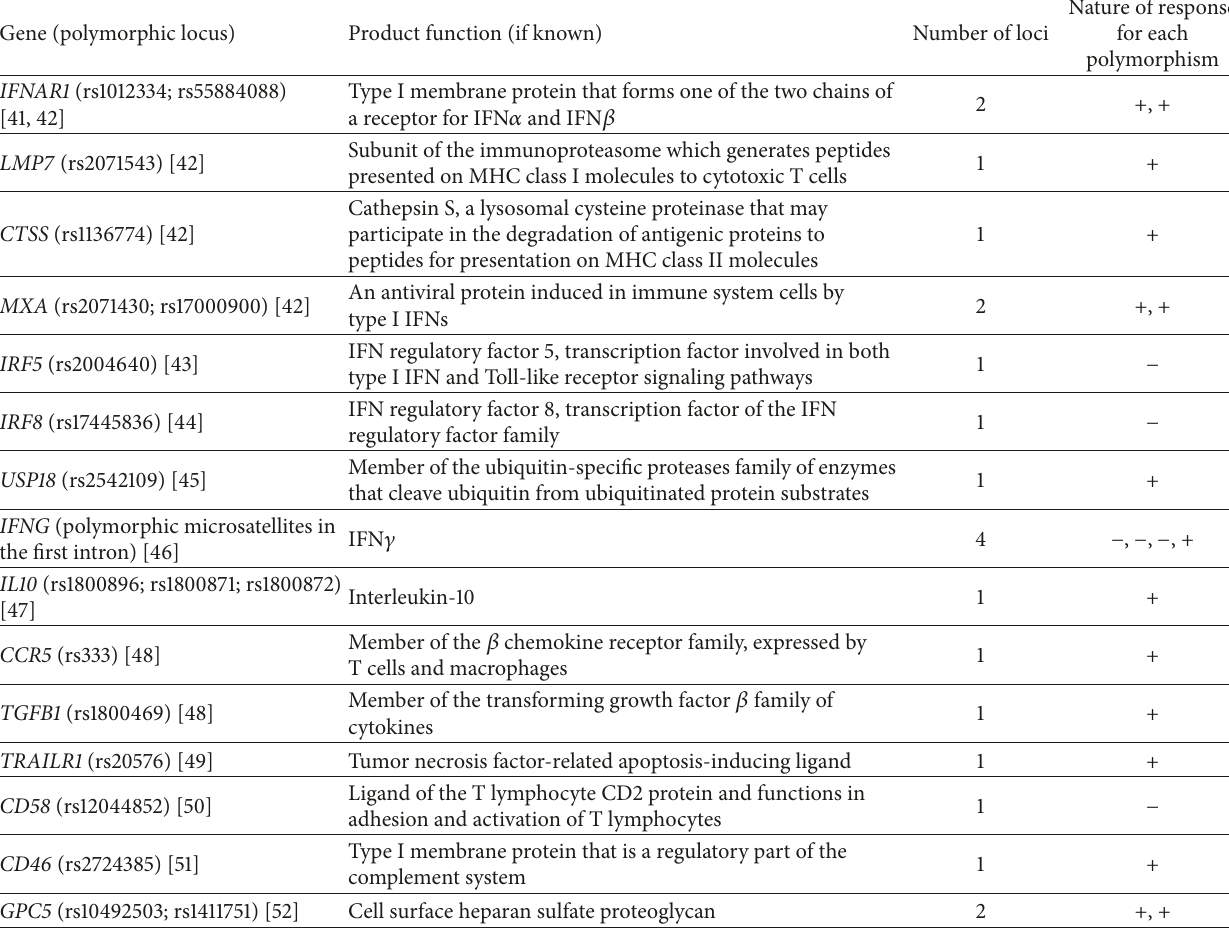
Table4:GeneswithpolymorphismsshowingsignificantassociationwithresponsetoIFN 𝛽 inpatientswithmultiplesclerosisfromcandidate- gene studies